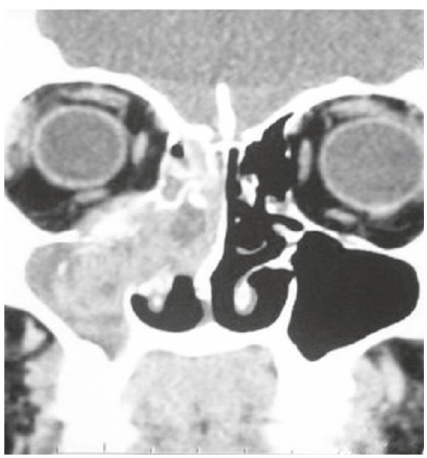
Figure 1: Computed tomography (CT)scan showing a mass causing an opacification of the right nasal cavity, ethmoid and maxillary sinuses.